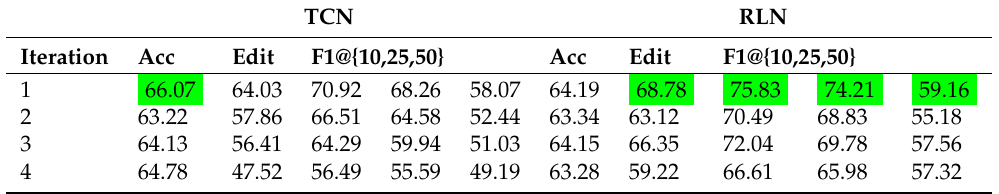
Table 5. RL-SSI in the Coffee context.